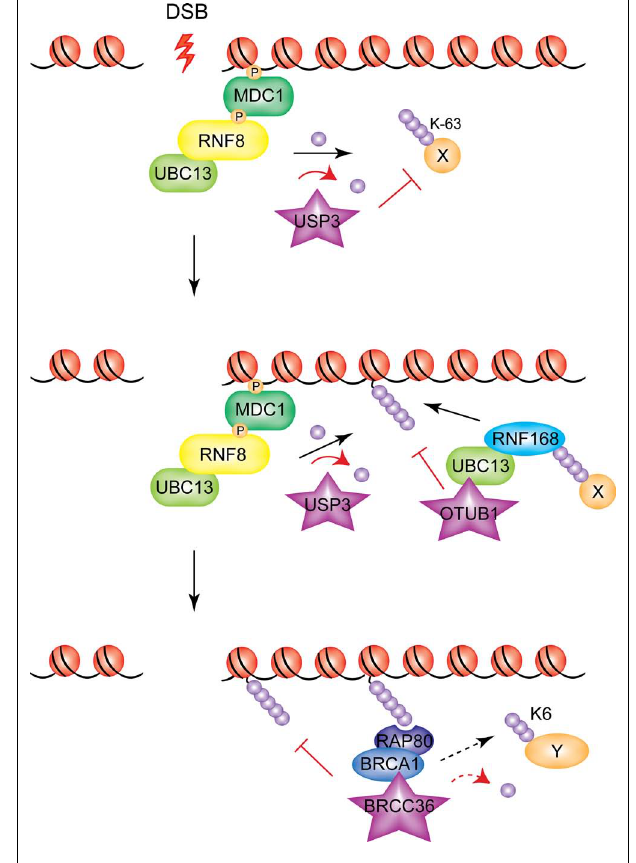
FIGURE 3 | Modulation of RNF8/RNF168 signaling through de-ubiquitylation. Different DUBs act at different levels of the RNF8/RNF168 cascade to inhibit, modulate, or turn off the ubiquitin signal generated by the two E3s. USP3 de-ubiquitylates RNF8 targets; OTUB1 acts on substrates of RNF168, and BRCC36 acts downstream, severing ubiquitin chains generated presumably by both E3s (and possibly also on BRCA1 targets, indicated by the dashed